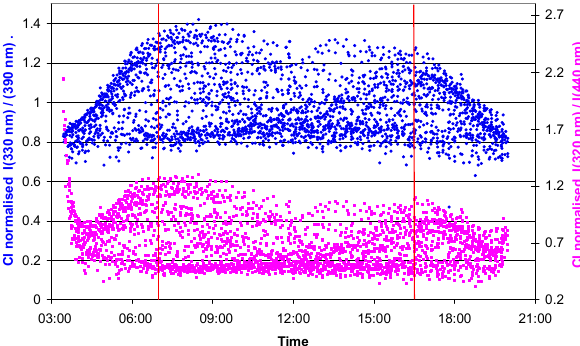
Figure 3. Normalised CI during CINDI for both wavelength pairs. The normalisation is performed by dividing the measured CI by the respective simulated minimum values. For SZA < 60 ◦ (indicated by the red vertical lines) the minima of the normalised CI are almost independent from the SZA. The measurements are from the period 12 June to 15 July